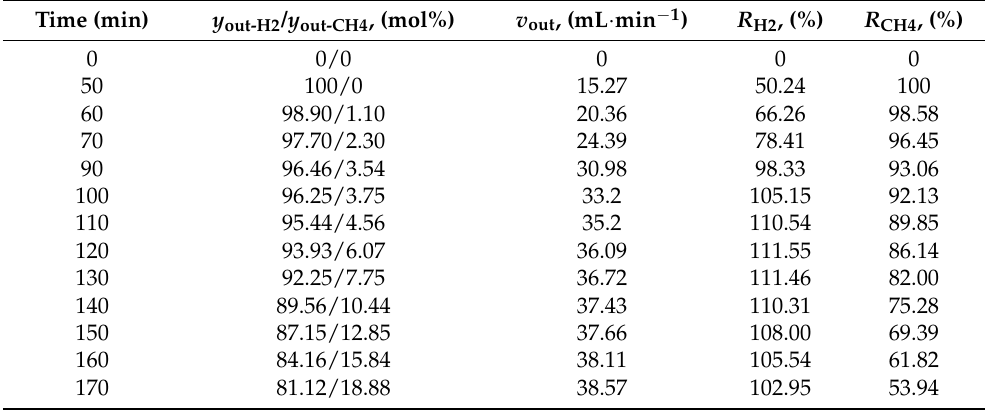
Table 5. The results of the breakthrough experiment for the CH 4 /H 2 (34.22/65.78 mol%) mixture separation in a slurry of ZIF-8 30 wt% + ethylene glycol 14 wt% + water 56 wt% at 273.15 K, 2.0 MPa, with an inlet flow rate of 46.20